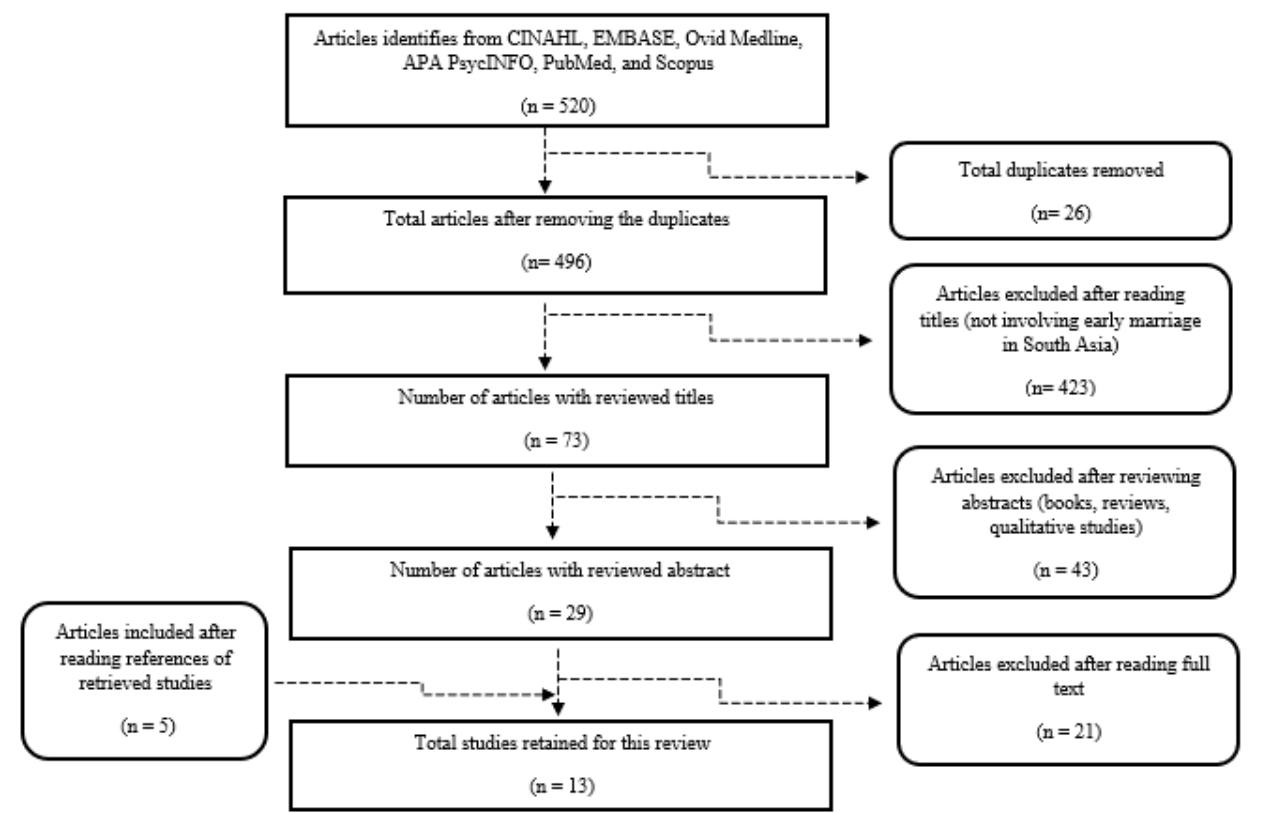
Figure 1. Flow chart for study selection based on PRISMA 2015 guidelines. Table 1. Summary of selected